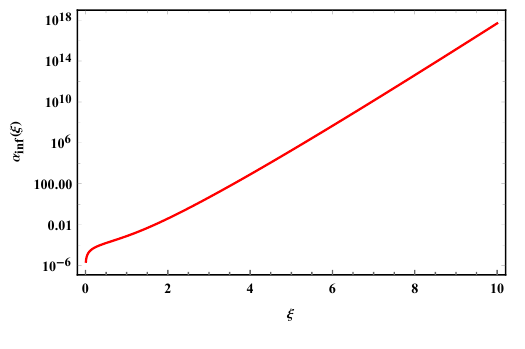
Figure 7 . The α inf ( ξ ) vs ξ in eq.